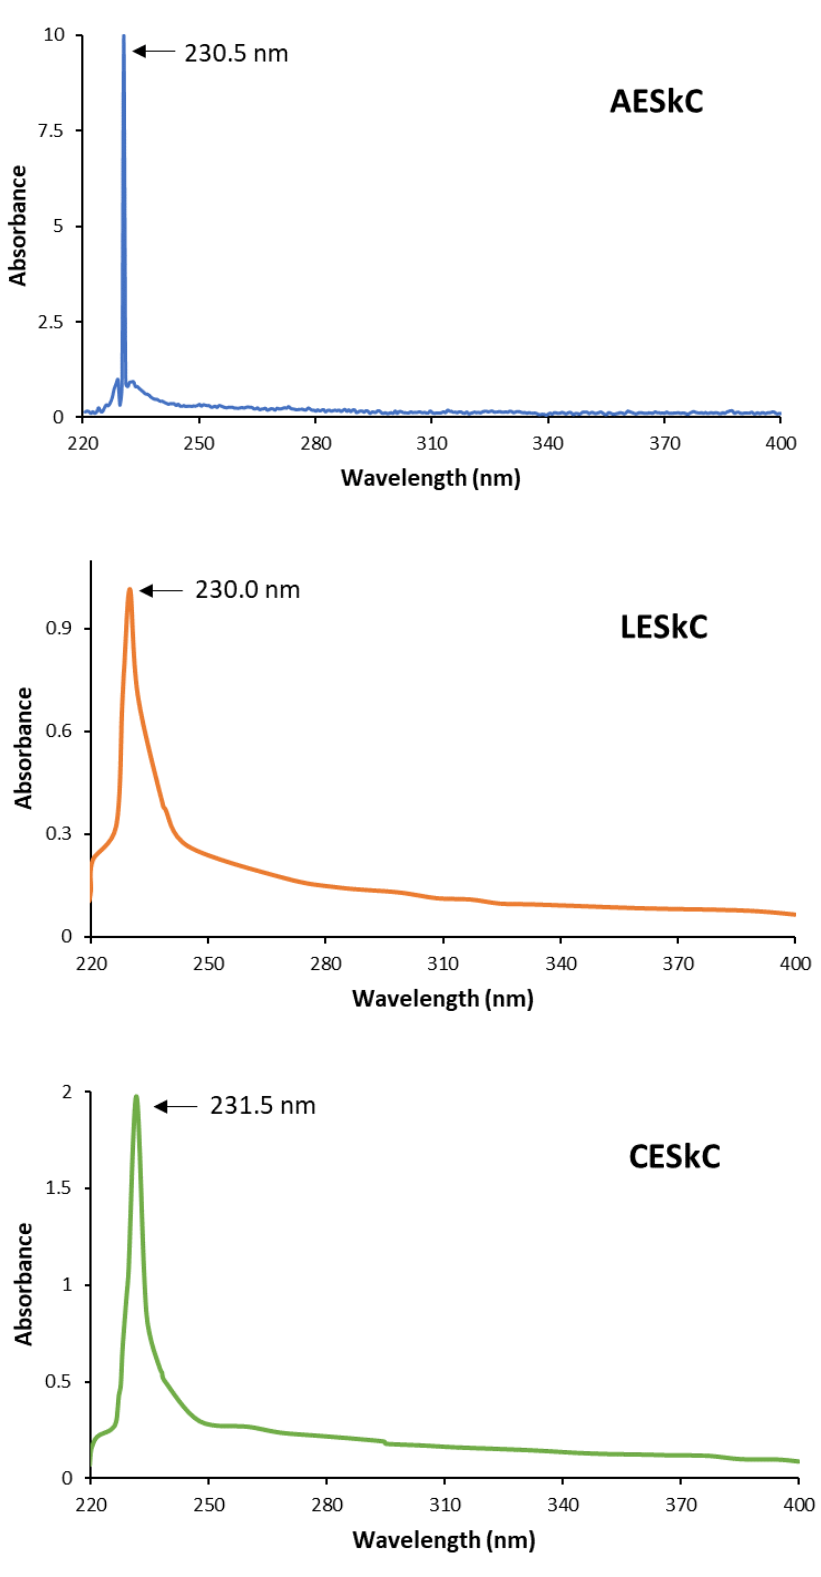
Figure 1. Ultraviolet absorption spectrum of collagens from the skin of lizardfish. AESkC: acetic acid-extracted collagen; LESkC: lactic acid-extracted collagen; CESkC: citric acid-extracted collagen.